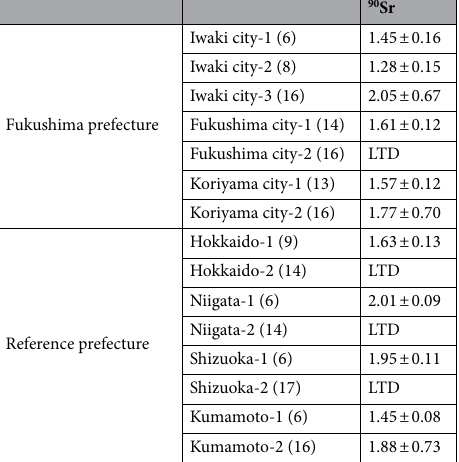
Table 2. Radioactivity of 90 Sr (mBq/g Ca) in deciduous teeth. Data are shown as mean ± counting error. Parentheses show numbers of teeth in a sample. When the counts did not exceed the mean + 3SD of the background, we considered the value as LTD (lower than detection limit). SD, standard